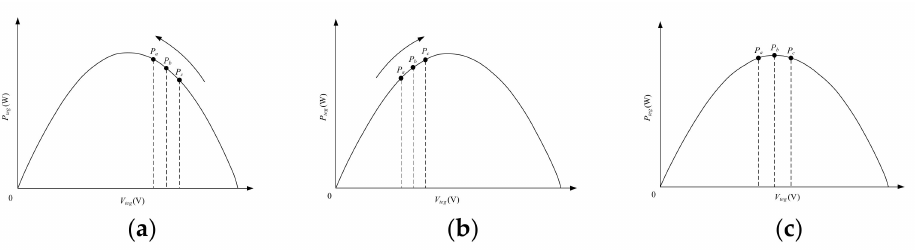
Figure 4. Three cases for the three-point weighting strategy. ( a ), P a > P b > P c ; ( b ), P a < P b < P c ; ( c ), P b > P a and P c .